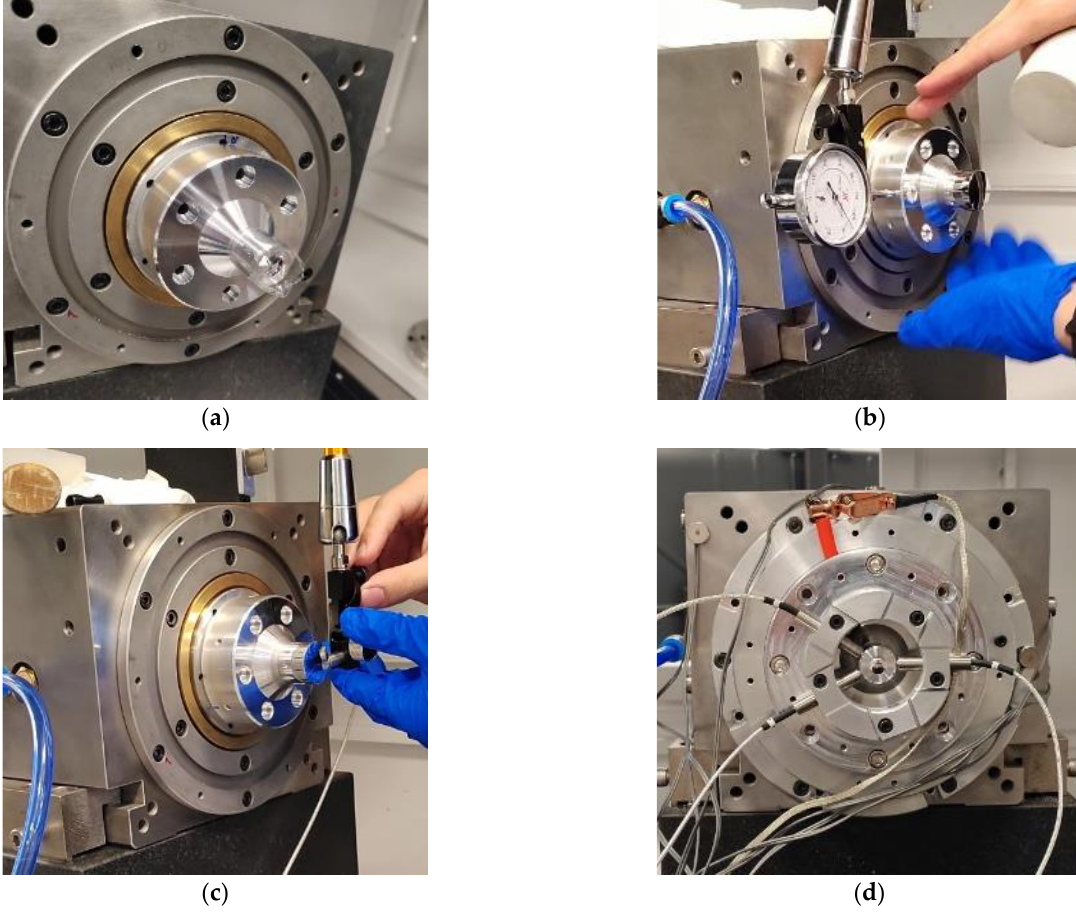
Figure 9. Detailed steps of radial error measurement using three-point method: ( a ) step 1: mounting of standard workpiece, ( b ) step 2: rough adjustment of standard workpiece, ( c ) step 3: fine adjustment of standard workpiece, ( d ) step 4: mounting fixture and sensor probes.